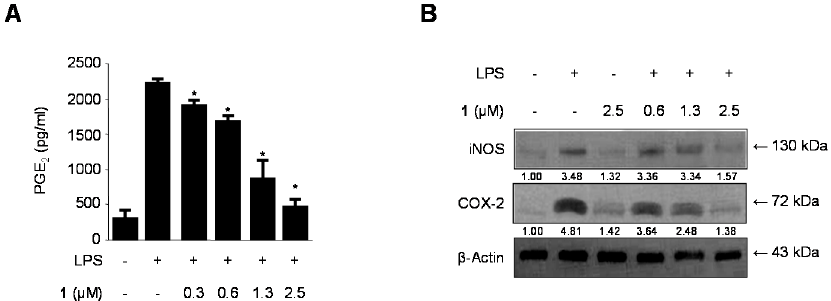
Figure 4. The effects of cudratricusxanthone A ( 1 ) on the PGE 2 production ( A ) and protein expression of iNOS and COX-2 ( B ) in BV2 microglia stimulated with LPS. Cells were pretreated for 3 h with the indicated concentrations of cudratricusxanthone A ( 1 ) and then stimulated for 24 h with LPS (1 µg/mL). The LPS treatment was performed in the presence of compound. The concentrations of iNOS and COX-2 ( B ) were determined as described in the Experimental Section. Western blot analyses were performed as described in the Experimental Section, and representative blots of three independent experiments are shown. The band intensity was quantified by densitometry and normalized to β -actin, and the values are presented at the bottom of the each band. Relative data represent the means ± SDs of three experiments. * p < 0.05 compared with the LPS-treated group. “+” is treated, “ − “ is not treated.